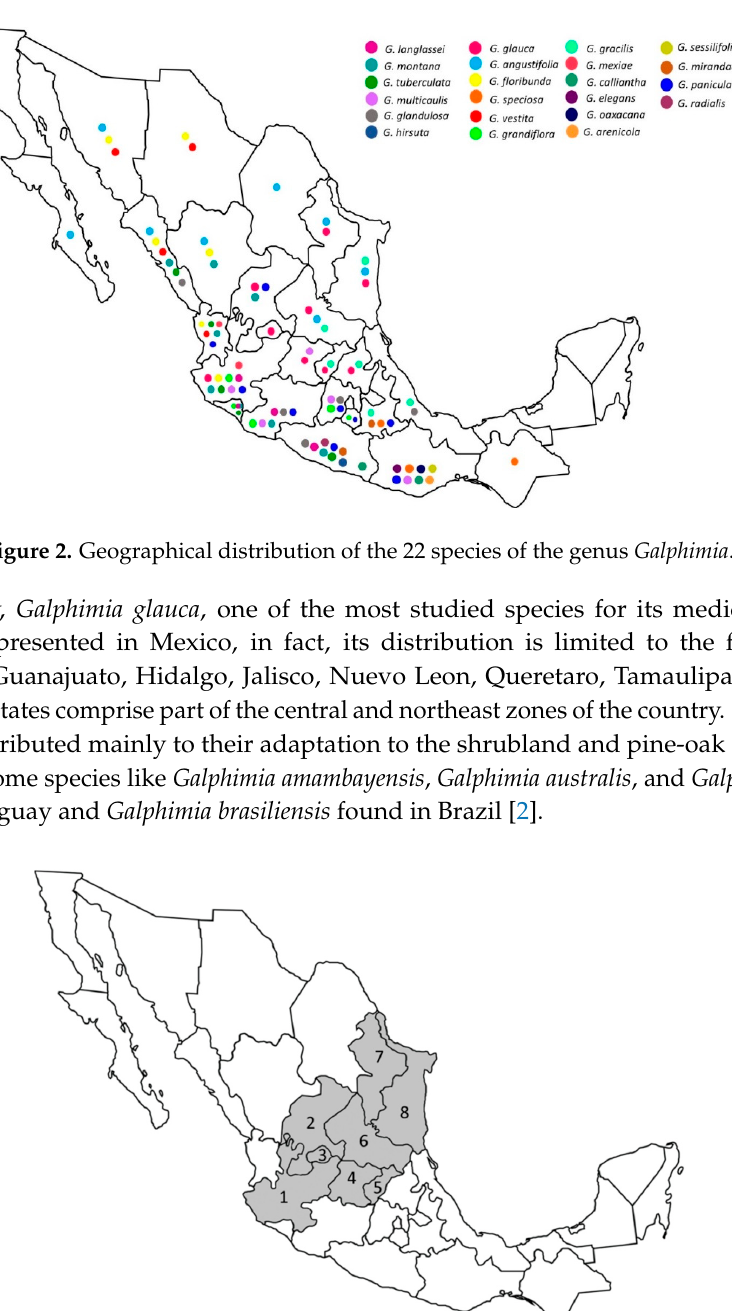
Figure 1. Galphimia glauca at different stages of development (photo courtesy of Ashutosh Sharma).